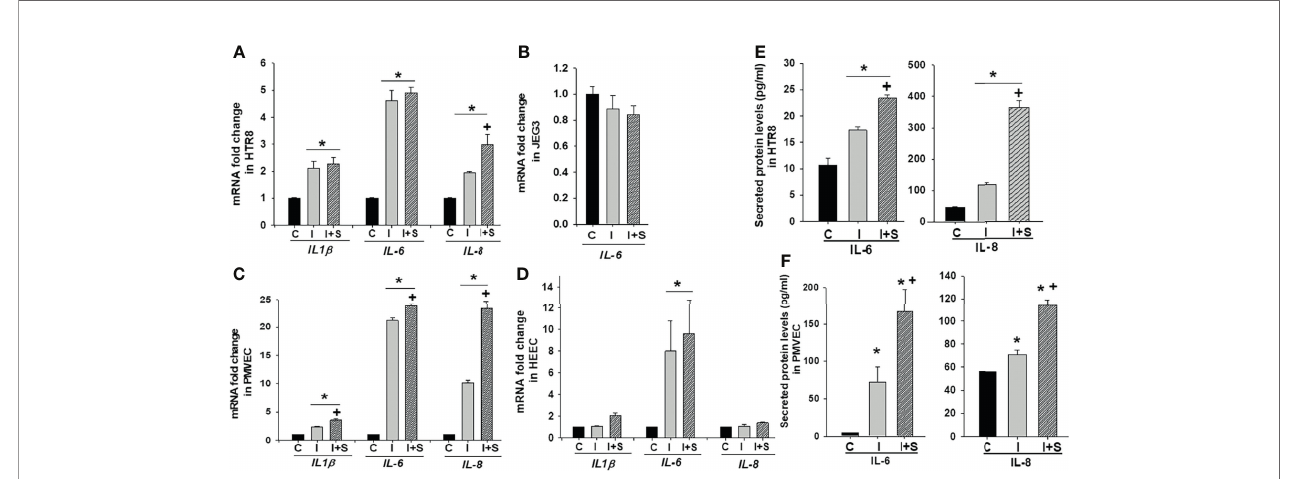
FIGURE 5 | IFN g with or without S-protein signi fi cantly increases expression of pro-in fl ammatory cytokines in trophoblastic and endothelial cell cultures. Expression of pro-in fl ammatory cytokines genes IL-1 b , IL-6 , IL-8 was measured in HTR8/SV neo (A) , JEG3 (B) , PMVECs (C) , and HEECs (D) treated with either control or 10 ng/ ml rh-IFN g ± 10 ng/ml rh-S-protein by qPCR. Bars represent mean ± SEM, n=3; * P<0.05 vs. control and + P<0.05 vs. rh-IFN g alone. ELISA results revealed to measure secreted IL-6 and IL-8 protein levels in HTR8 (E) and PMVECs (F) by treatment with 10 ng/ml rh-IFN g or rh-IFN g + 10 ng/ml rh-S-protein. Bars represent mean ± SEM, n=3; * P<0.05 vs . control. + P<0.05 vs . IFN g alone. C, Control; I, rh-IFN g ; and I+S, rh-IFN g + rh-S-protein.